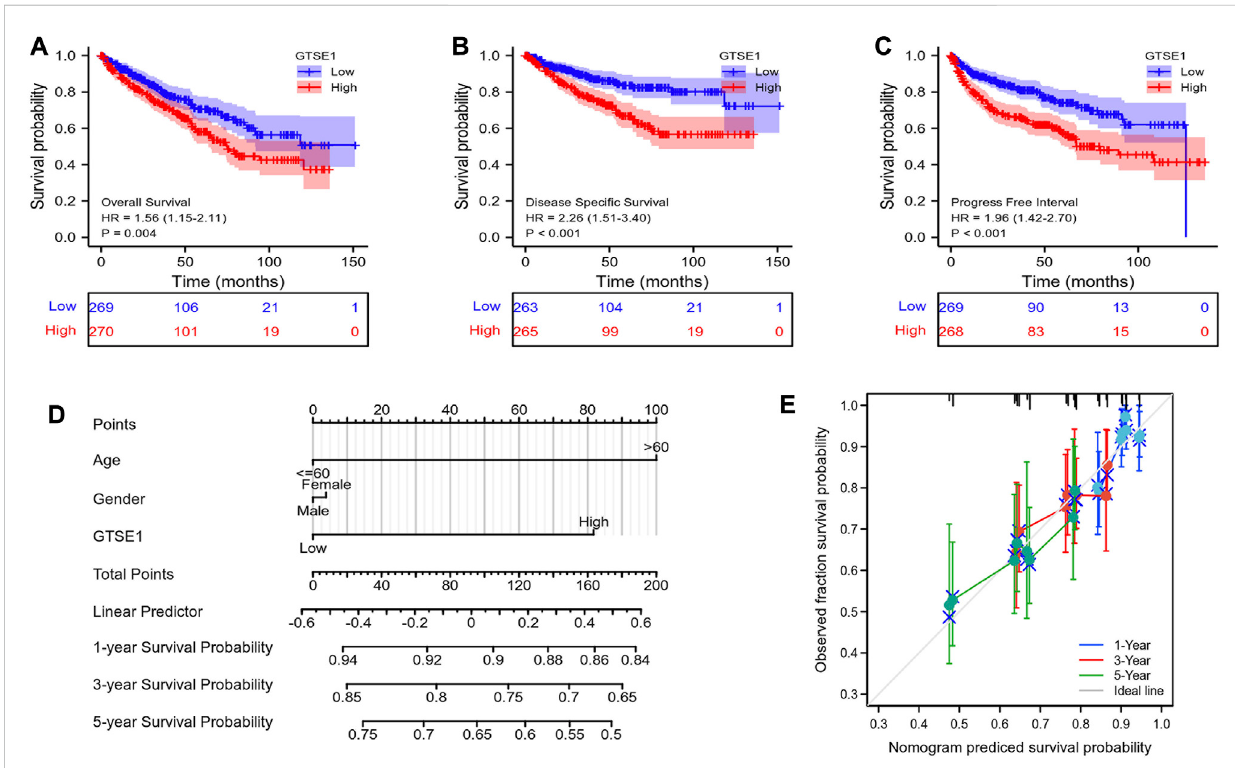
FIGURE 3 Prognostic value of GTSE1 in ccRCC. Kaplan – Meier survival curve analysis of OS (A) , DSS (B) and PFI (C) veri fi ed the prognostic value of GTSE1 in ccRCC. (D) Nomogram used to predict the probability of 1-, 3-, and 5-year OS for ccRCC patients based on the patient ’ s age, gender, and GTSE1 expression level. (E) Calibration plot of the nomogram for predicting the OS likelihood.